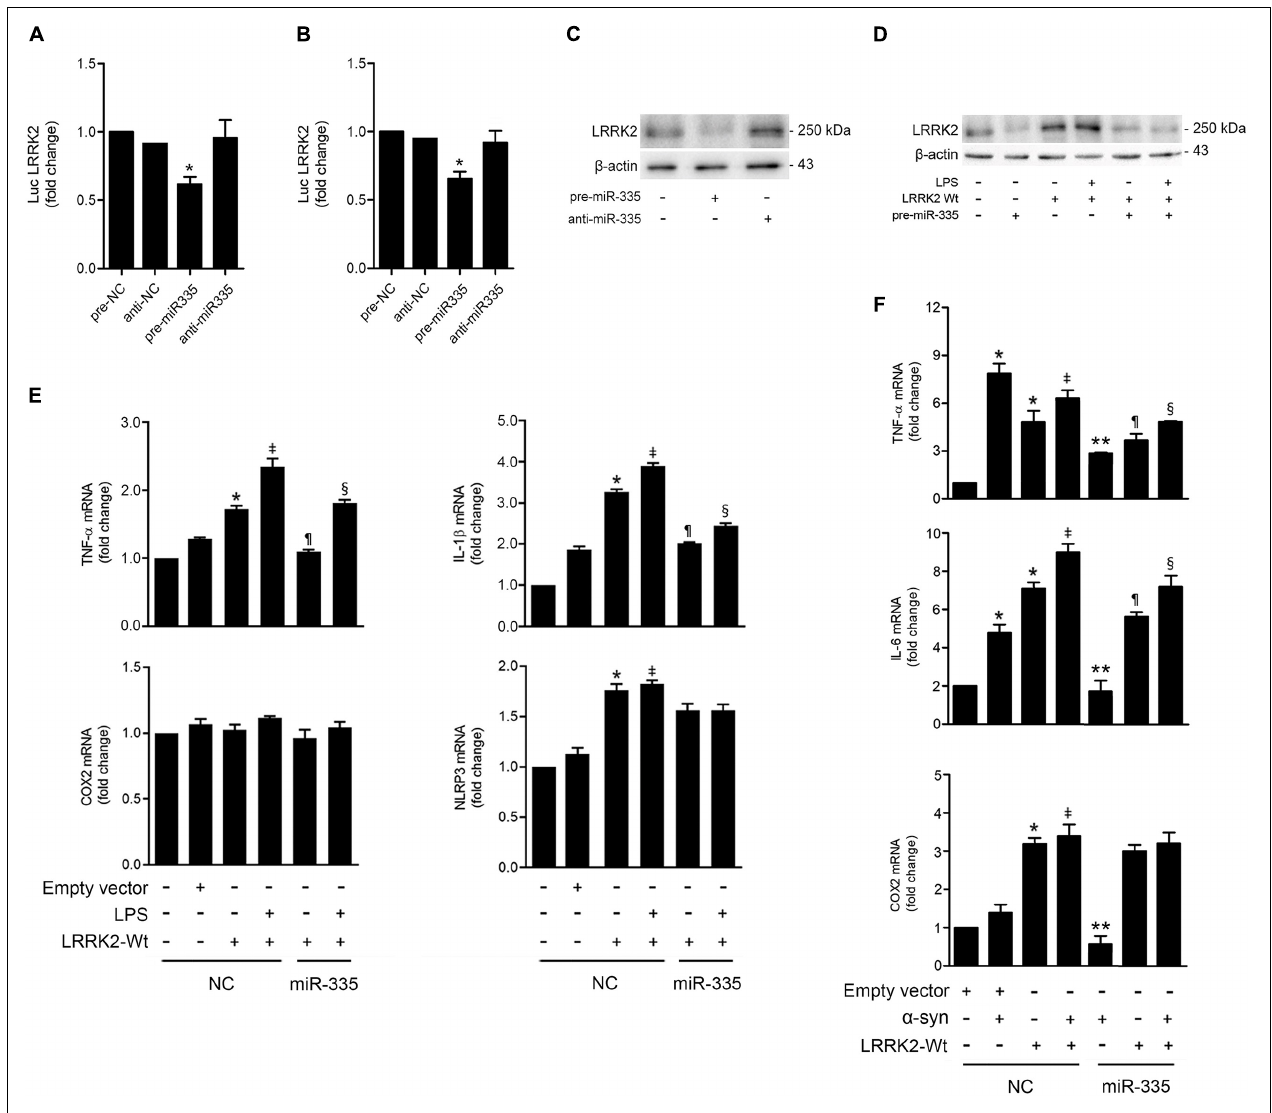
FIGURE 5 | MiR-335 directly targets LRRK2. (A) SH-SY5Y cells were co-transfected with a LRRK2 luciferase reporter vector, or negative control, and pre-miR-335/pre-NC; or anti-miR-335/anti-NC for 24 h. (B) BV2 cells were co-transfected with a LRRK2 luciferase reporter vector, or negative control, and pre-miR-335/pre-NC; or anti-miR-335/anti-NC for 24 h. Renilla luciferase signal was used as an internal standard control. Results are presented as mean ± SEM of three independent experiments. * p < 0.0.5 vs. pre-NC. (C) Representative immunoblots are presented for LRRK2 in SH-SY5Y cells. β -Actin was used as loading control. (D) BV2 cells were co-transfected with a LRRK2-Wt or empty vector plasmid and with a pre-miR-335 or pre-NC for 24 h, and then stimulated with LPS for additional 24 h. Representative immunoblots are presented for LRRK2. β -Actin was used as loading control. (E) Modulation of LRRK2-Wt-induced proinflammatory mRNA levels by miR-335. BV2 cells were co-transfected with a LRRK2-Wt or empty vector plasmid and with a pre-miR-335 or pre-NC for 24 h, and then stimulated with LPS for additional 24 h. TNF- α , IL-1 β , COX2, and NLRP3 mRNA levels were measured by qRT-PCR. Results are expressed as mean ± SEM from three independent experiments. * p < 0.05 vs. empty vector; } p < 0.05 vs. empty vector transfected with pre-NC, p < 0.05 vs. LRRK2-Wt; p < 0.05 vs. LRRK2-Wt exposed to LPS. (F) Modulation of LRRK2-Wt-induced proinflammatory mRNA levels by miR-335. SH-SY5Y cells with or without overexpression of α -syn were co-transfected with a LRRK2-Wt or empty vector plasmid and with a pre-miR-335 or pre-NC for 24 h. TNF- α , IL-1 β , and COX2 mRNA levels were measured by qRT-PCR. Results are expressed as mean ± SEM from three independent experiments. * p < 0.05 vs. empty vector; } p < 0.05 vs. empty vector transfected with pre-NC, ** p < 0.05 vs. NC overexpressing α -syn; p < 0.05 vs. LRRK2-Wt without α -syn overexpression; p < 0.05 vs. LRRK2-Wt with α -syn